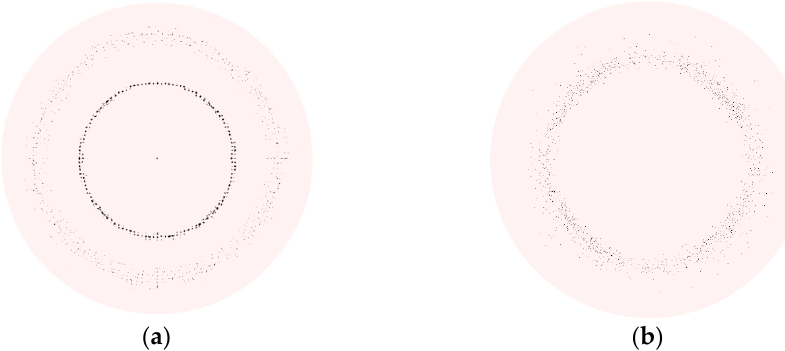
Figure 3. The deposition of spherical particles on the impaction plate. ( a ) “halo” for Re = 400, stk = 0.25. ( b ) “ring” for Re = 700, stk = 0.25. stk = 0.25. ( b ) “ring” for Re = 700, stk =